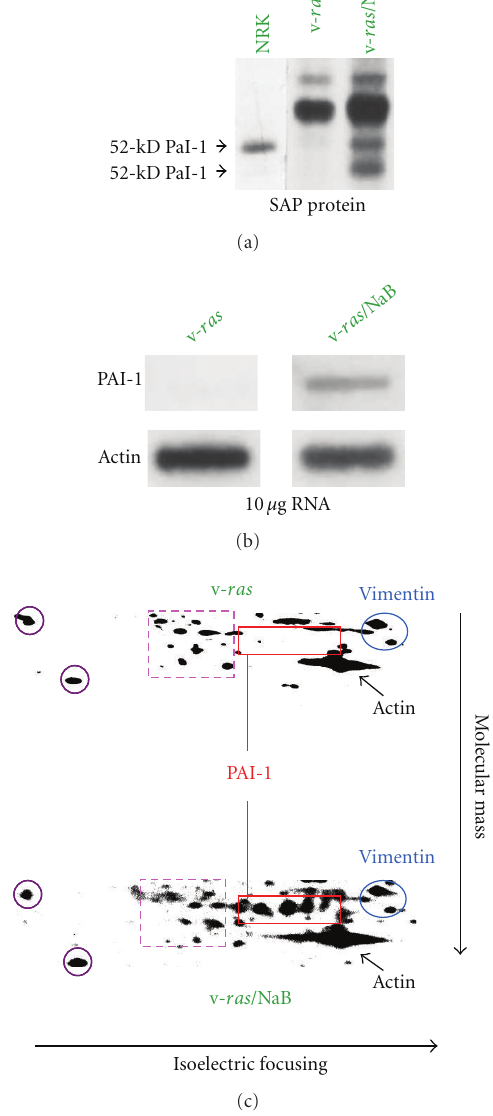
Figure 1: Electrophoresis of the 35 S-methionine-labeled saponin- resistant (SAP) protein fraction of v- ras -transformed renal cells and their NaB-treated counterparts indicated that PAI-1 (both the 50- kD and fully glycosylated 52-kD species) were expressed in NaB revertants but not in untreated cells (a). PAI-1 from normal kidney cells (NRK) served as a marker. The band above PAI-1 in v- ras cells (at 62-kD) is the heavily-glycosylated forms of osteopontin (a). Northern blotting confirmed the absence of PAI-1 mRNA in v- ras - transformants and the restoration of mRNA expression in response to NaB (b). 2-D electrophoretic mapping of the SAP fraction proteins derived from 35 S-methionine-labeled cultures revealed, furthermore, that PAI-1 induction in response to NaB treatment was rather selective (c). Map positions of the glycosylated PAI- 1 isoforms are indicated (solid red outlined rectangle). Proteins common between the cell types are highlighted in color (purple circles, red dashed line box, blue ovals indicating vimentin, and phosho-vimentin breakdown products and actin by black arrows) and did not change in abundance despite the significant PAI-1 induction evident in the v- ras /NaB protein profile